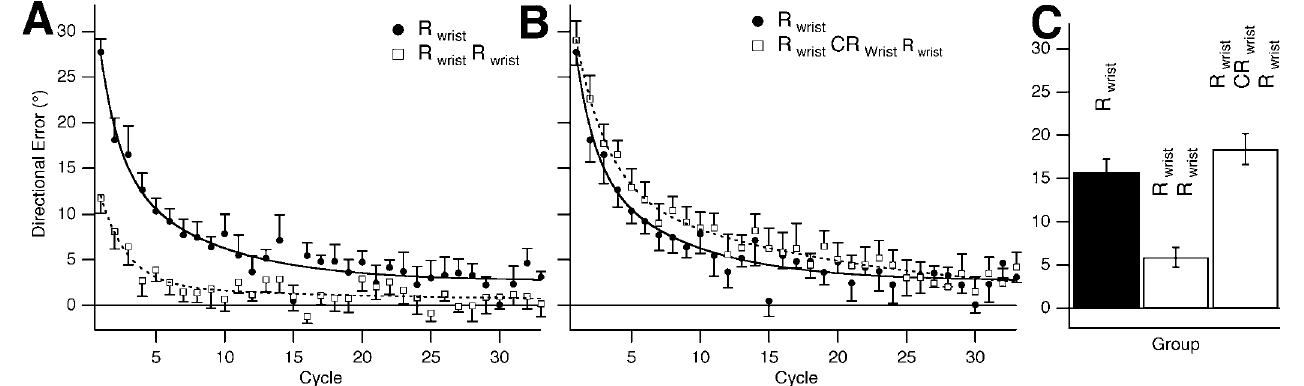
Figure 1. Savings and Interference Occur for Rotation Learning at the Wrist (A) R wrist on day 1 (group 1, black circles and black curve) and on day 2 (group 2, white squares and dashed curve). Learning is shown by progressive reduction across cycles in the directional error at peak velocity. Points, representing the group average with standard error for each cycle, are fitted by a double-exponential function. There were substantial savings from day 1 to day 2. (B) R wrist on day 1 (group 1, black circles and black curve) and after interference on day 2 (group 3, white squares and dashed curve). There were no savings from day 1 to day 2 after interference with CR wrist . (C) Bar graph showing a statistically significant difference in the reduction in mean directional error in the first six cycles for day 1 versus day 2 (groups 1 and 2, mean difference ¼ 9.86 8 , p , 0.0001). This difference is absent with interference, with no statistically significant difference in the reduction in mean directional error in the first six cycles for day 1 versus day 2 (groups 1 and 3, mean difference ¼(cid:1) 2.64 8 , p ¼ 0.22). DOI: